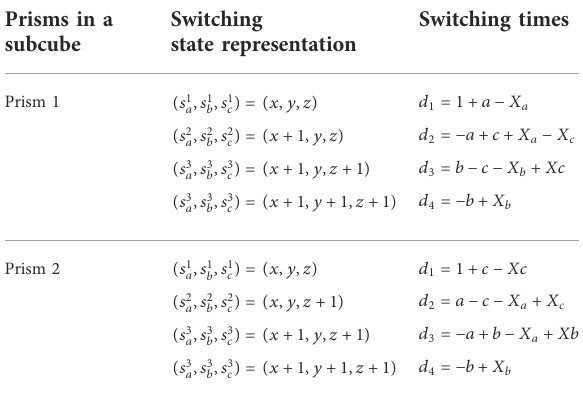
TABLE 1 Switching time computation for various prisms in a subcube.